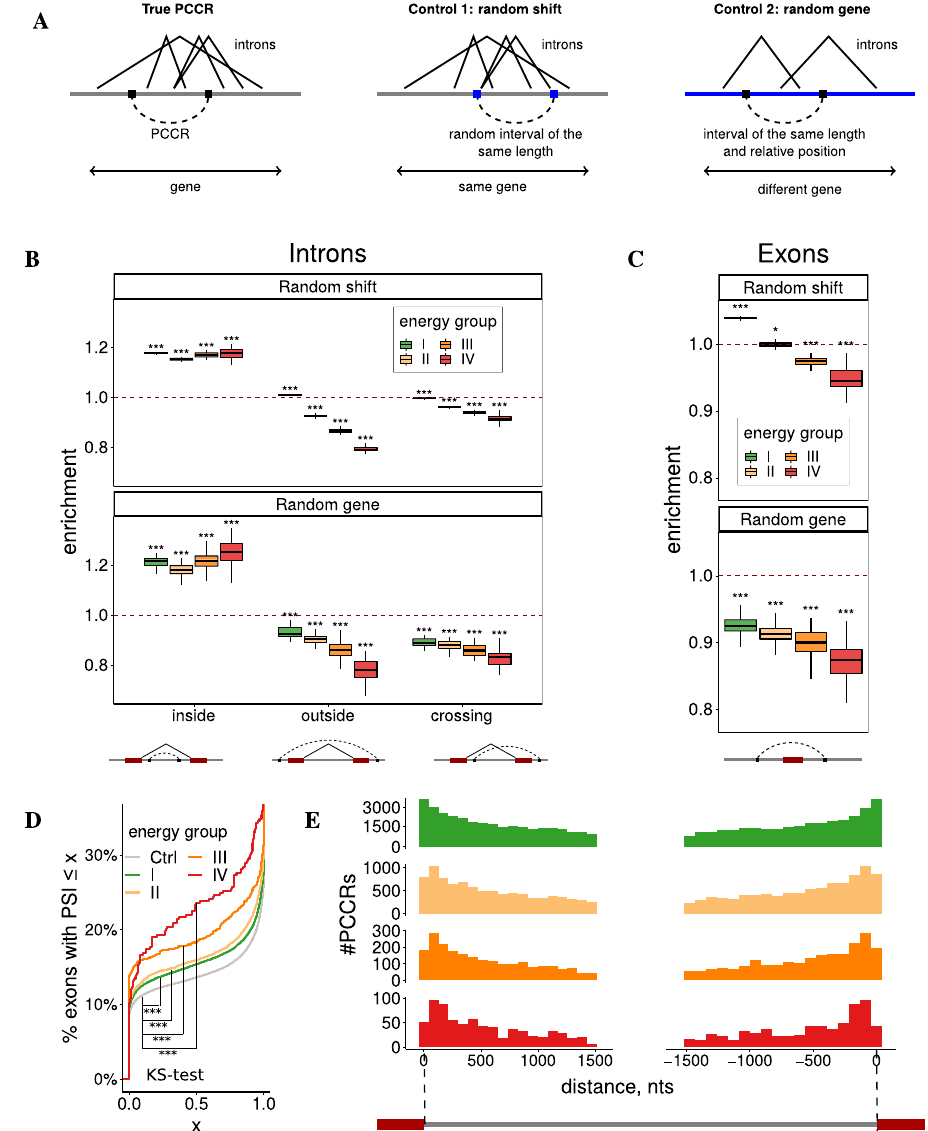
Fig. 3 Splicing. A Control procedures. In the random shift control, a PCCR is shifted within the gene. In the random gene control, a pseudo-PCCR is created in the same relative position of a different gene chosen at random. The number of PCCRs inside, outside, and crossing the reference set of intervals (e.g., introns) are counted. B PCCRs are enriched inside introns and depleted in outside and crossing con fi gurations. C PCCRs looping out exons are depleted. D The cumulative distribution of the average exon inclusion rate ( Ψ ) in HepG2 cell line for exons looped out by PCCRs of the four energy groups vs. exons not looped out by PCCRs (Ctrl). KS denotes the two-sample Kolmogorov – Smirnov test. Sample sizes for energy groups I – IV and control are n = 73,366, 13,974, 1877, 374, and 161,947, respectively. E The distribution of distances from intronic PCCRs to intron ends (bin size 75 nts). Group I PCCRs are enriched, while group IV PCCRs are depleted in 75-nt windows immediately adjacent to splice sites. In all panels, boxplots (represented by the median, upper and lower quartiles, upper and lower fences; outliers are not shown) correspond to n = 40 randomizations; * and *** denote a statistically discernible difference at the 5% and 0.1% signi fi cance level, respectively (in panels B and C for a two-tailed Wilcoxon ’ s test with H 0 : enrichment =